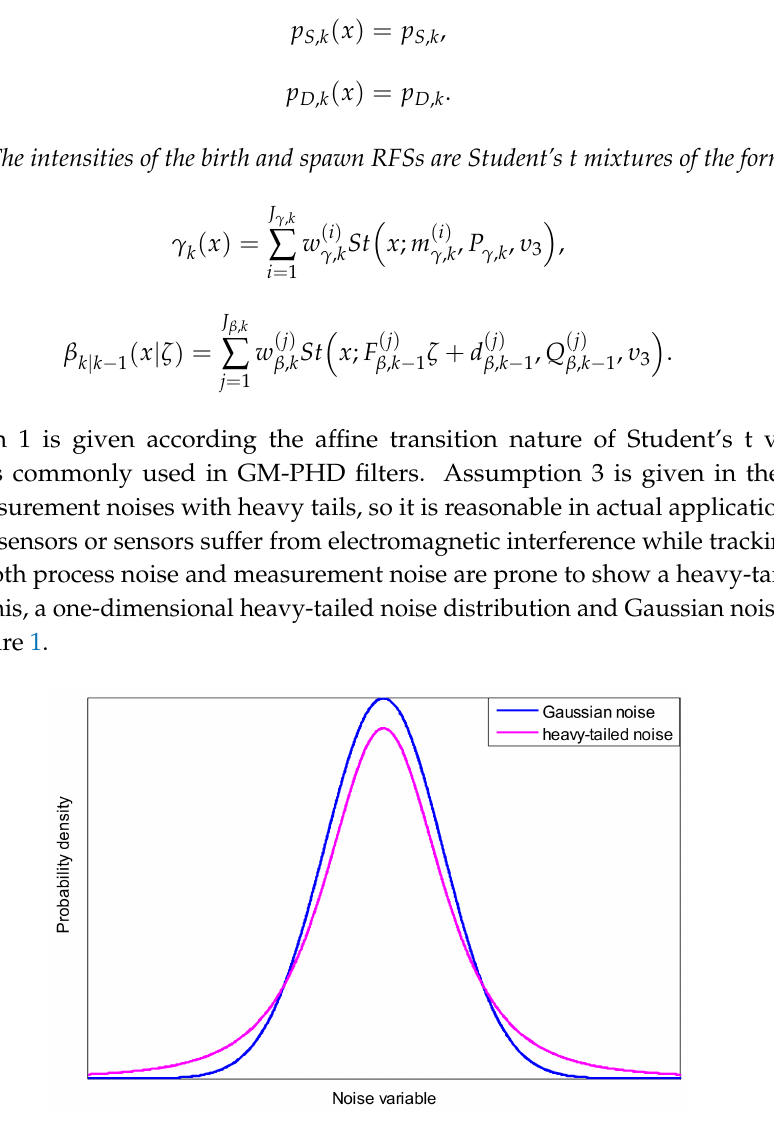
Figure 1. Illustration of heavy-tailed noise distribution and Gaussian noise